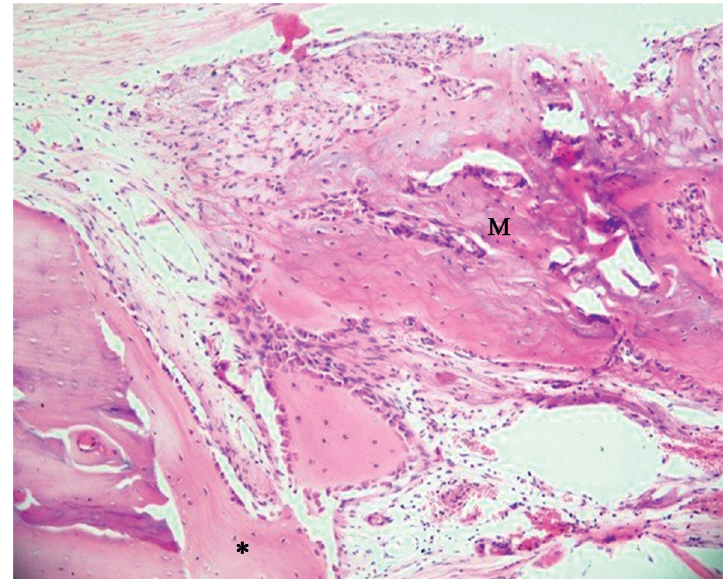
Figure 9 - Group AB+PBMT+M: Bone formation at the region of the membrane (M) and margin of the surgical defect (*) (40x) Table 1- Means, standard deviations (SD), Q25, medians and Q75 values of area of newly formed bone in % (ANB), and comparison between groups (Tukey Groups